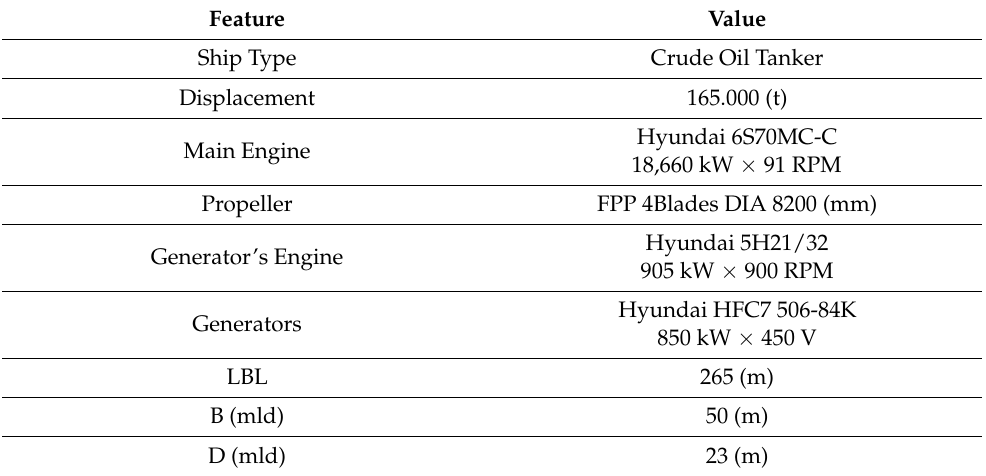
Table 1. The reference ship’s main